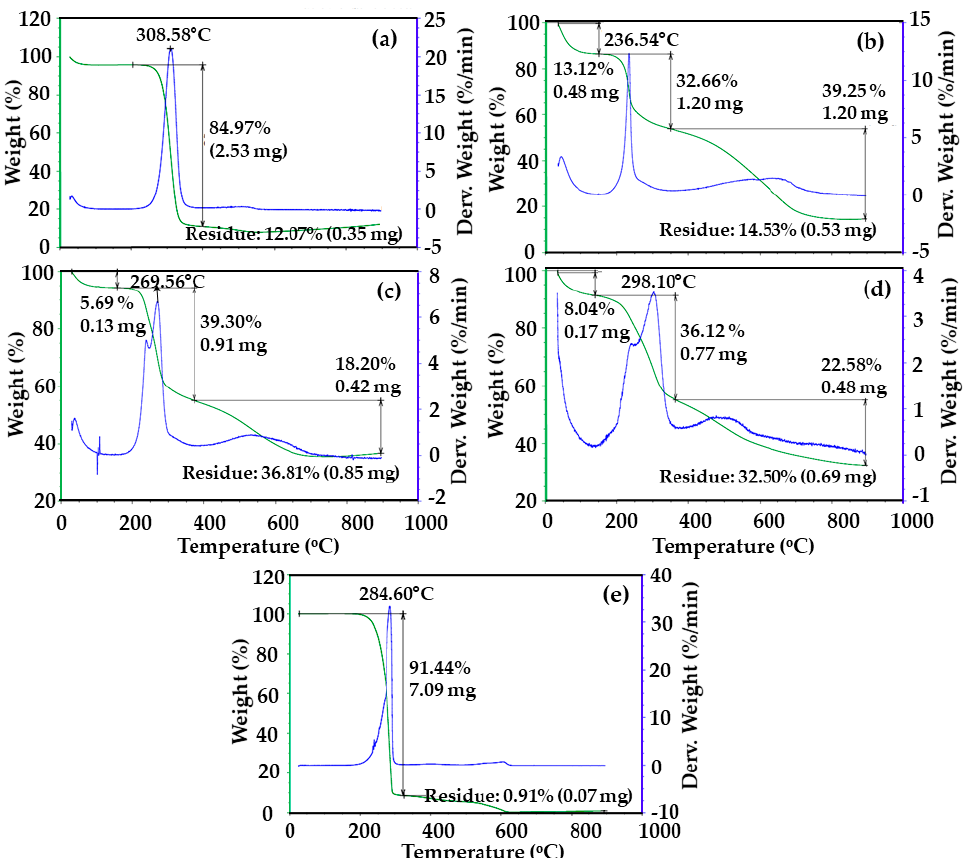
Figure 4. TGA and DTGA traces of ( a ) CF, ( b ) CS NPs, ( c ) CS-CF BNCs, ( d ) CS-CF/5FU BNCs and ( e ) 5FU.